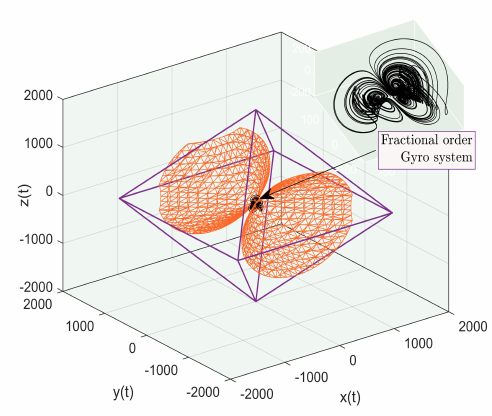
Figure 3. Bounded fractional order Gyro chaotic system inside octahedron. Figure 4 illustrates synchronization of fractional gyro chaotic system and its observer.